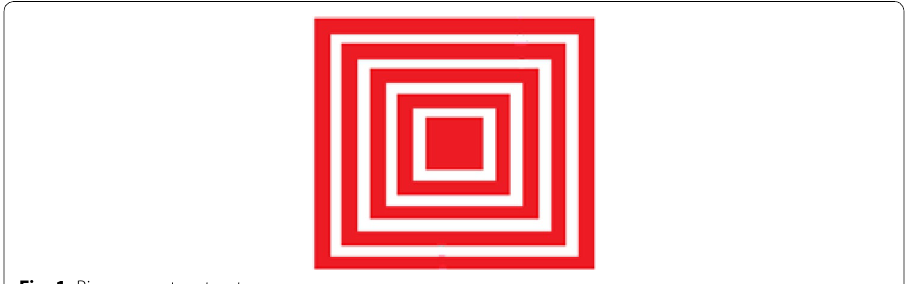
Fig. 1 Ring resonator